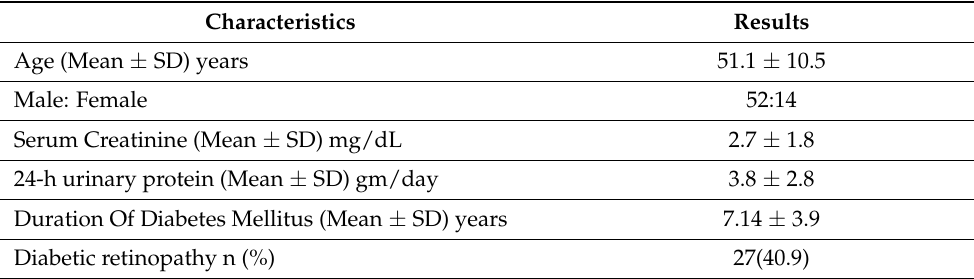
Table 1. The clinical characteristics of patients with type 2 diabetes mellitus (n =